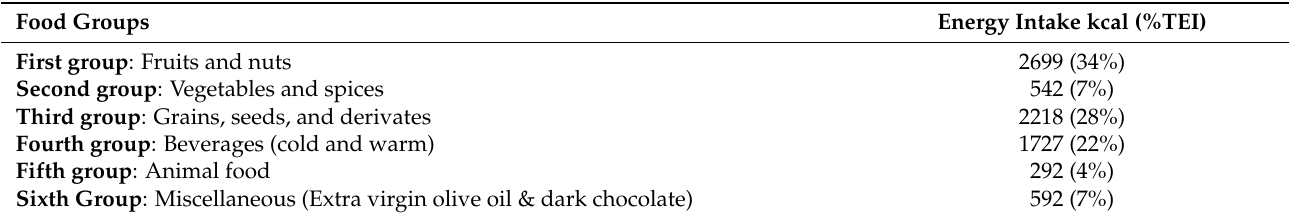
Table 3. Energy intake from different food groups.